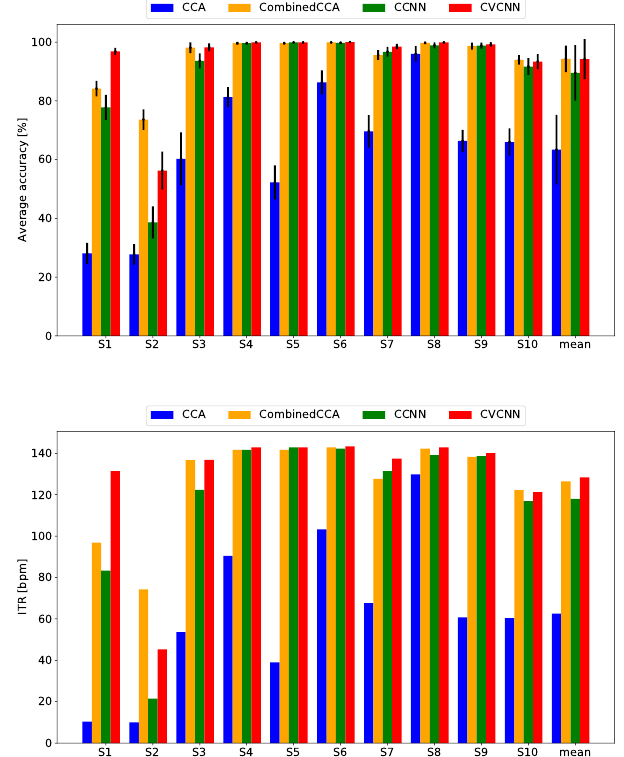
Figure 6. Classification accuracy and ITR for the open dataset with a data length of 1000 ms.